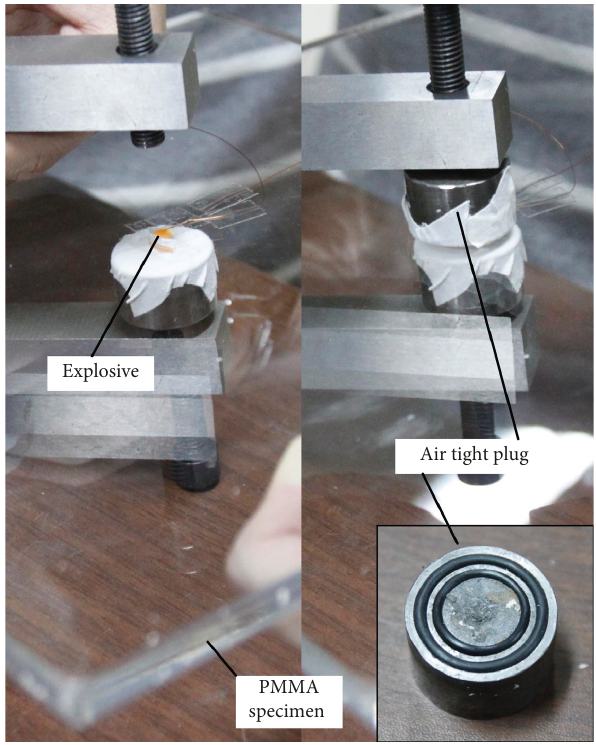
Figure 1: Airtightness of the